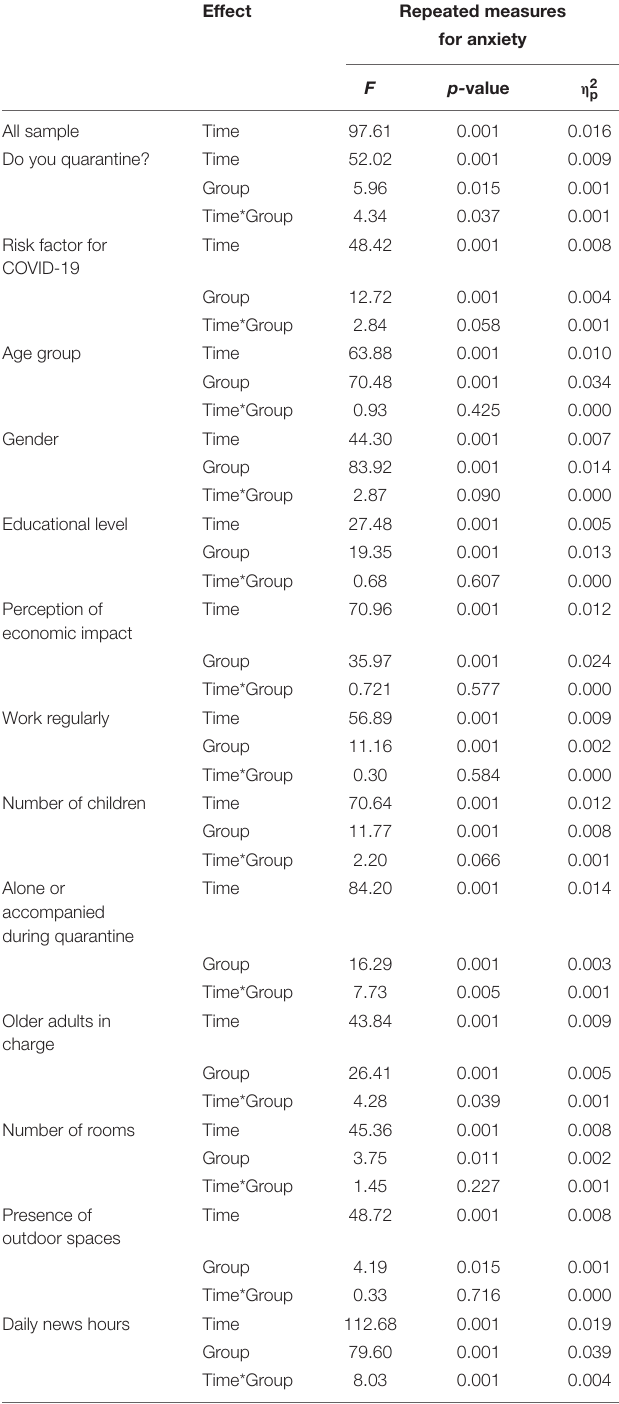
TABLE 5 | Results of repeated measures ANOVA for anxiety. Effect Repeated